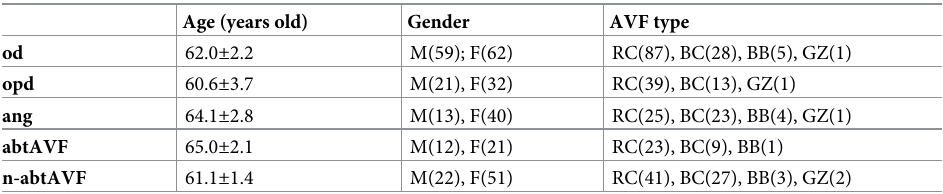
Table 2. Patient demographic data.